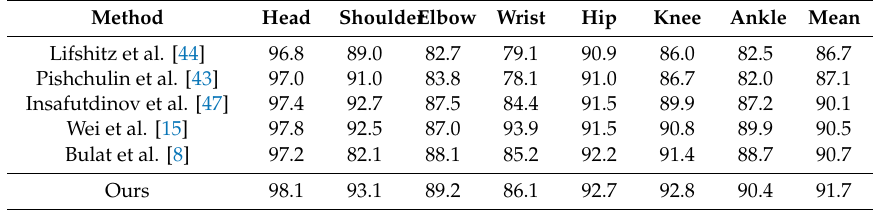
Table 7. Accuracy comparison with existing methods using the LSP validation dataset